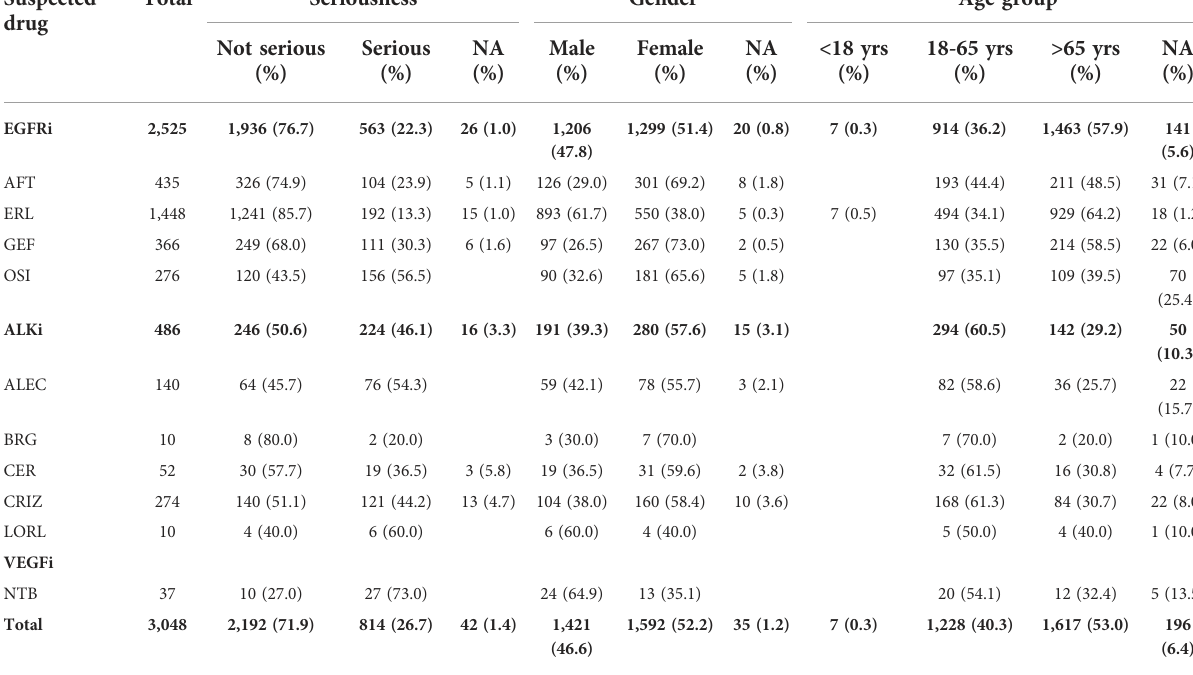
TABLE 1 Descriptions of Italian ADR reports related to TKIs for NSCLC collected into the RAM system from January 2006 to December